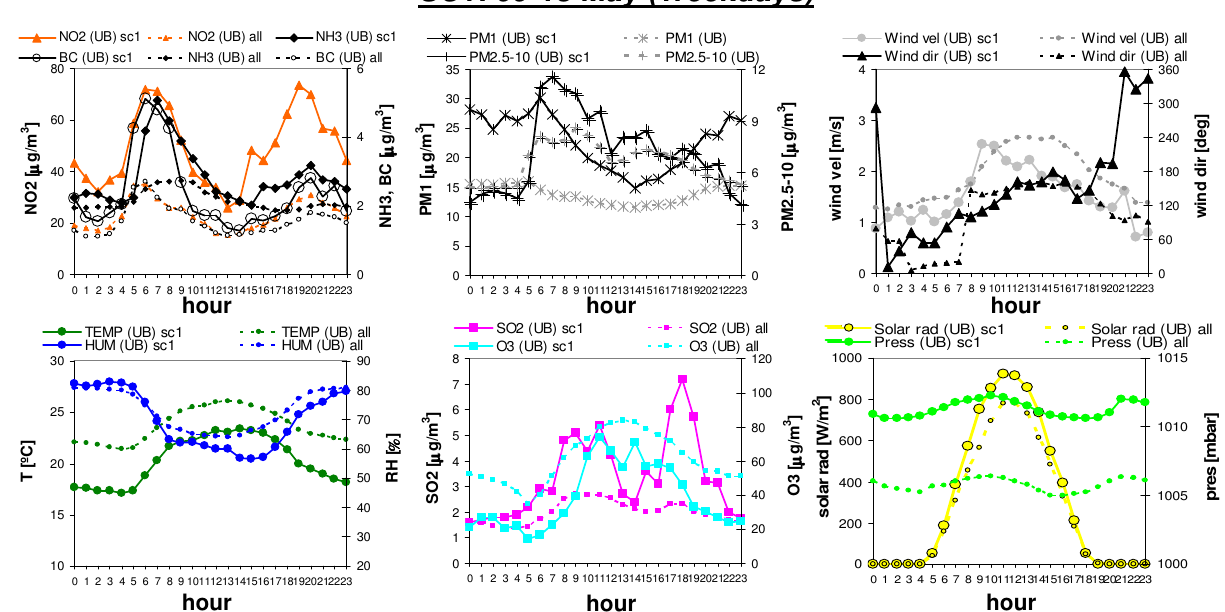
Fig. 10. Mean diurnal cycles of aerosol components and parameters measured at UB station during the period 9–13 May (Special Case 1). SC2: 01-05 Aug (Weekdays)